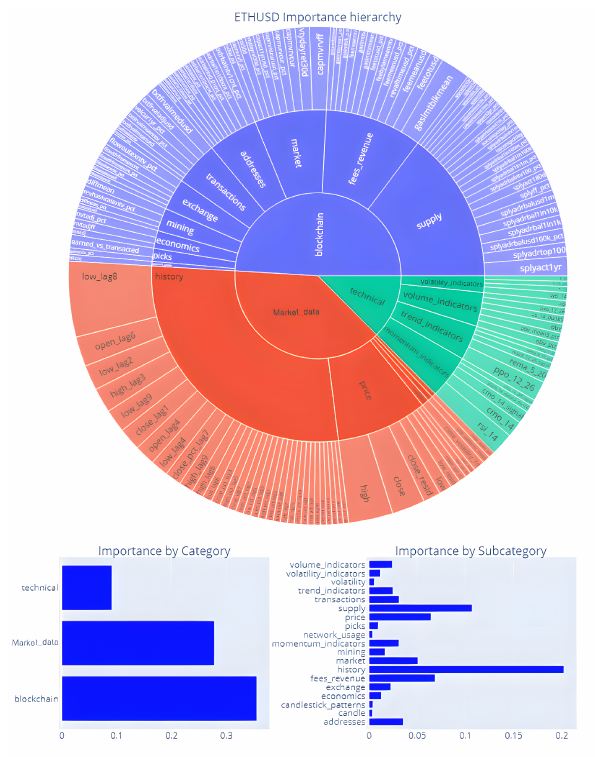
Figure 5. Hierarchical mean feature importance for